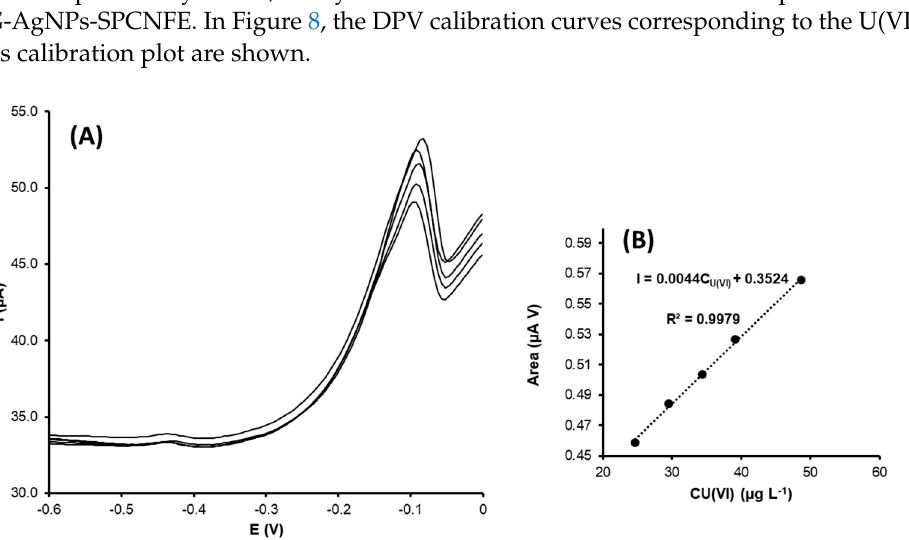
Figure 8. ( A ) DPV voltammograms for U(VI) and ( B ) calibration plot obtained using G-AgNPs- SPCNFE in acetic acid/acetate buffer 0.1 mol L − 1 pH 4.5 using an E d of − 1.2 V and a t d of 300 s.